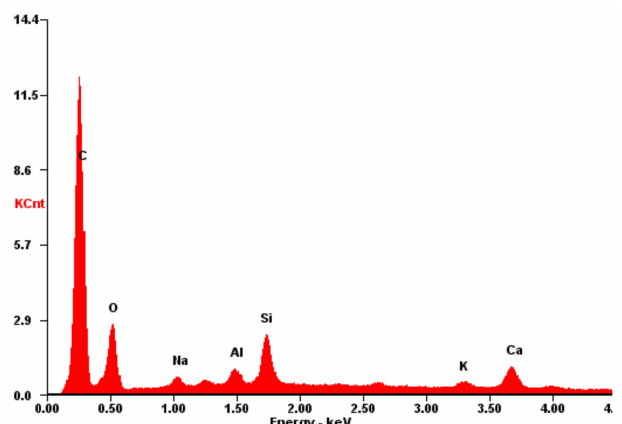
Figure 11. A typical EDS spectrum registered for the textolite material with advanced degradation effects. On the surface, there is a significant share of the elements present in the fibreglass support, namely, silicon and